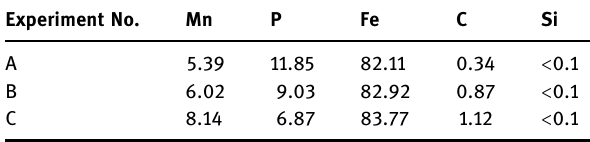
Table 2: Chemical compositions of the metal droplets after experiments ( mass fraction, % )